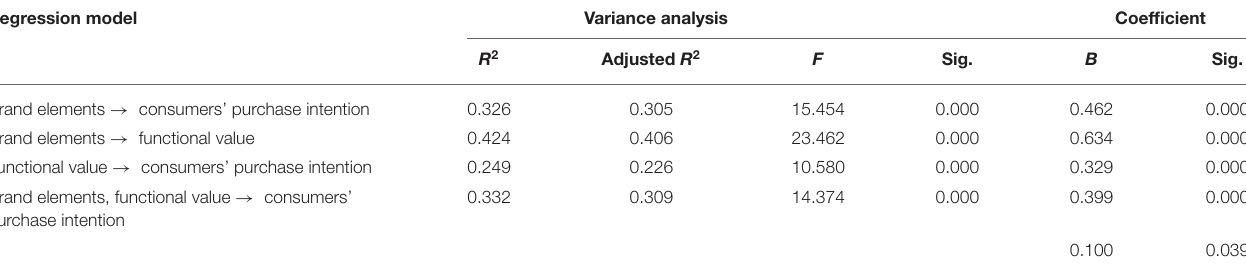
TABLE 11 | Intermediary role played by the functional value.